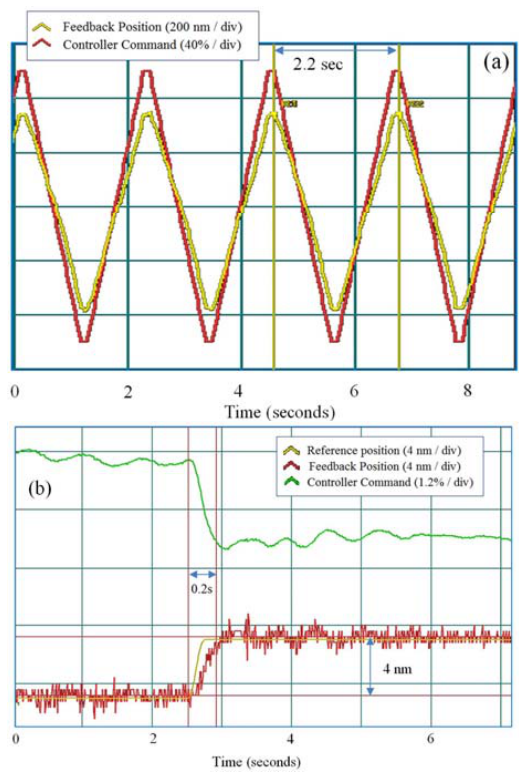
Figure 9. The use of an L1B2 motor in actuator (DC) mode. ( a ) The motion of a linear stage with a moving weight of 2 kg, driven by a NM HR8 motor (containing eight L1B2 elements) operating in a DC mode: position and controller command level as function of time. ( b ) Example of a 4 nm position step, performed with a Nanomotion FB75-100-HR8 stage operating in DC mode, equipped with a NM HR8 motor. The resolution of the feedback position encoder is 0.4 nm.